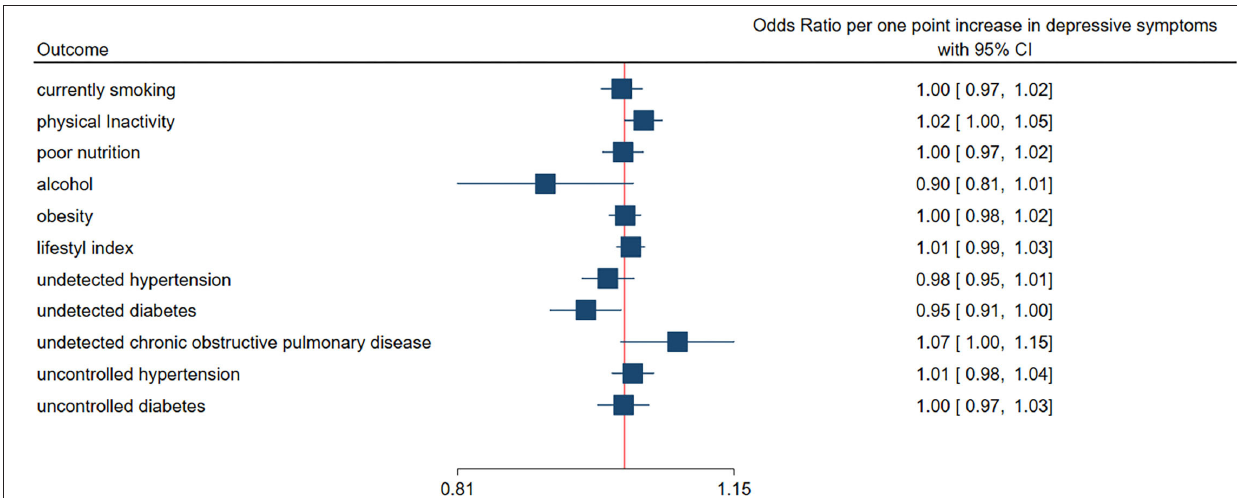
FIGURE 2 | Association between depressive symptoms (continuous score) and primary, secondary and tertiary prevention negative indicators. Squares indicate the odds ratio per one-point increase in depressive symptoms. Lines indicate the 95% confidence interval. Depressive symptoms were assessed using the Depression, Anxiety, Stress Scale-21. Mixed ordinal logistic regression models quantified the association between depressive symptoms and lifestyle index. The associations between depressive symptoms and all other outcomes were quantified with mixed logistic regression models. All models included municipality as a random effect and were adjusted for age, sex, work status, education level, living in a rural or urban setting, and ethnicity with exception of alcohol, which was reduced to adjustment for only age, sex and